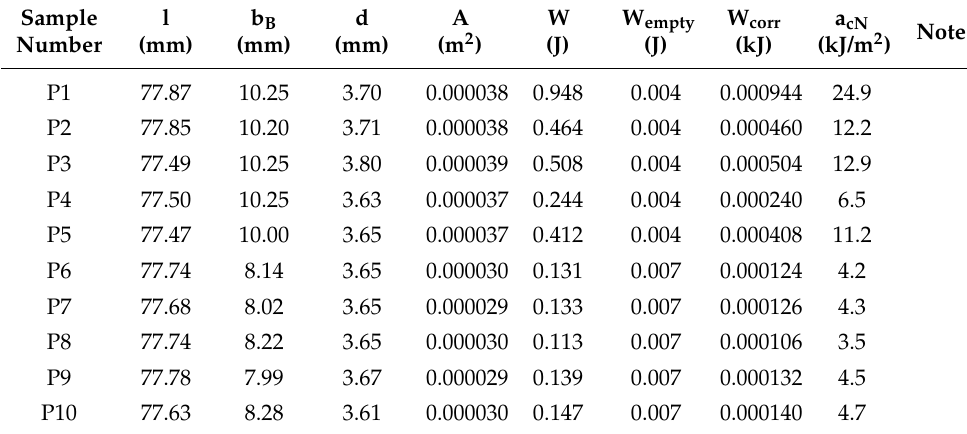
Table A13. Results of the notched impact tests and unnotched impact tests of P_W,C,PP. Sample